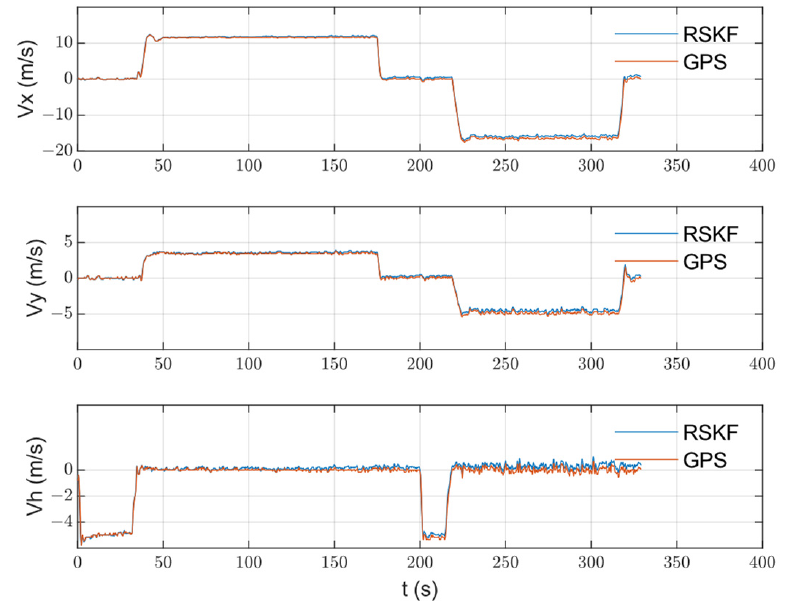
Figure 9. The calculated RSKF position with the reference position on the three axes.